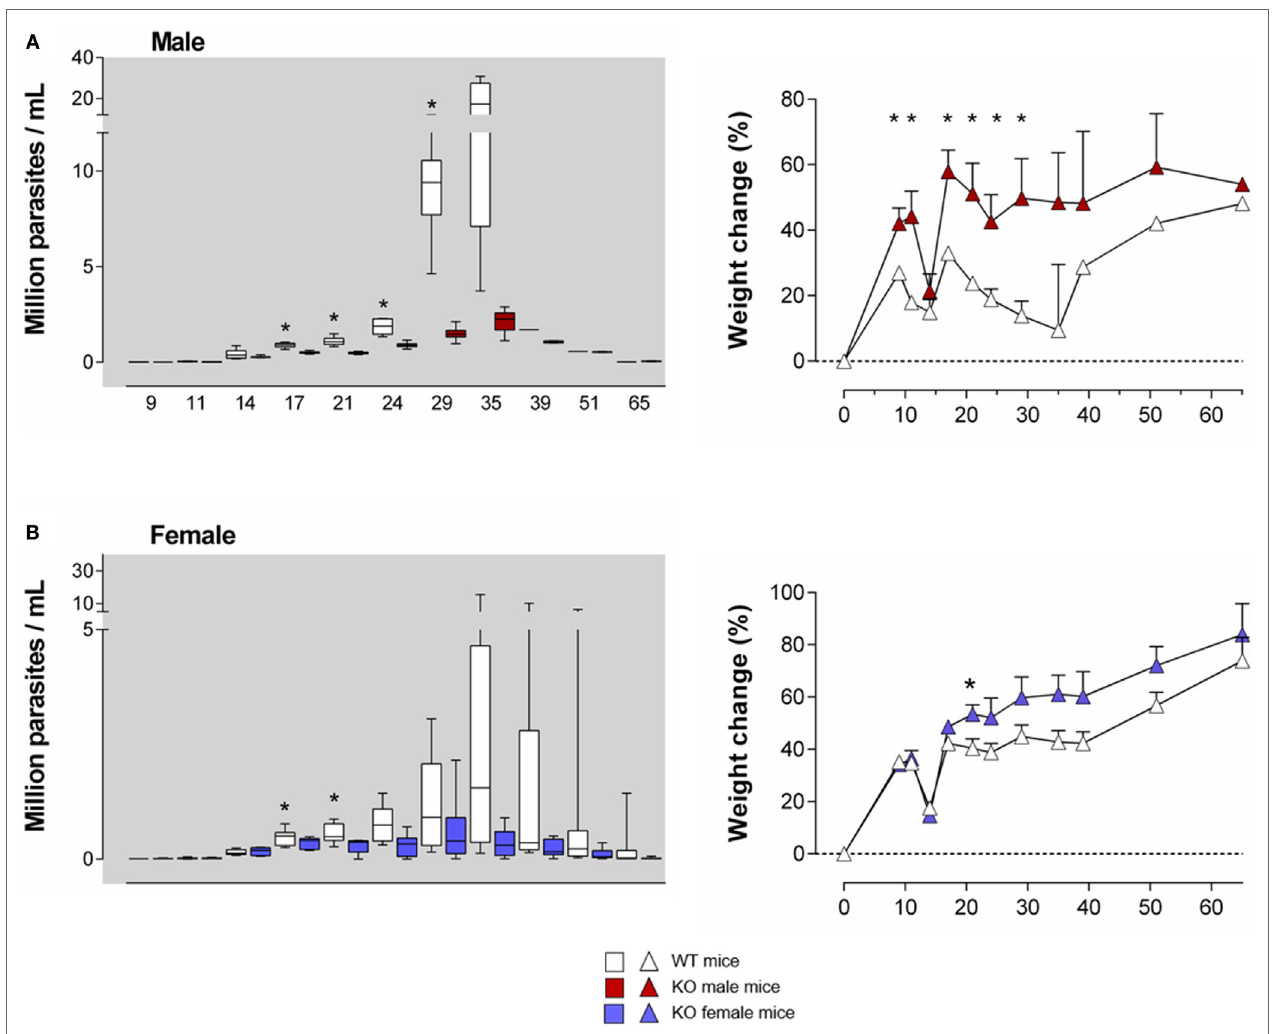
FigUre 2 | T. cruzi infection is better controlled in young ly49e KO mice compared to their WT controls . Four-week-old WT and Ly49E KO male (a) and female (B) mice were inoculated s.c. with 50 trypomastigotes at day 0. Blood parasitemia levels were examined microscopically at the indicated time points, as indicated in the left panels of (a,B) . The change in body weight is shown in the right panels (initial weight at the time of infection is set at 0). Results are expressed as Box and Whiskers showing the median from 4 WT and 4 KO male mice and 12 WT and 6 KO female mice. Significant differences between WT and Ly49E KO mice are indicated with * p < 0.05 (Mann–Whitney U